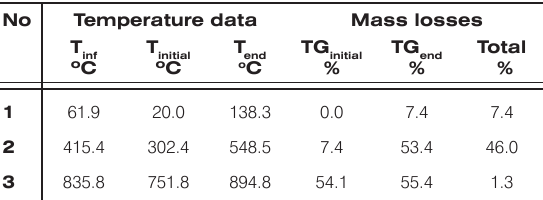
Table 1. Mass losses and temperature intervals of DTA/ TG analysis of samples obtained at